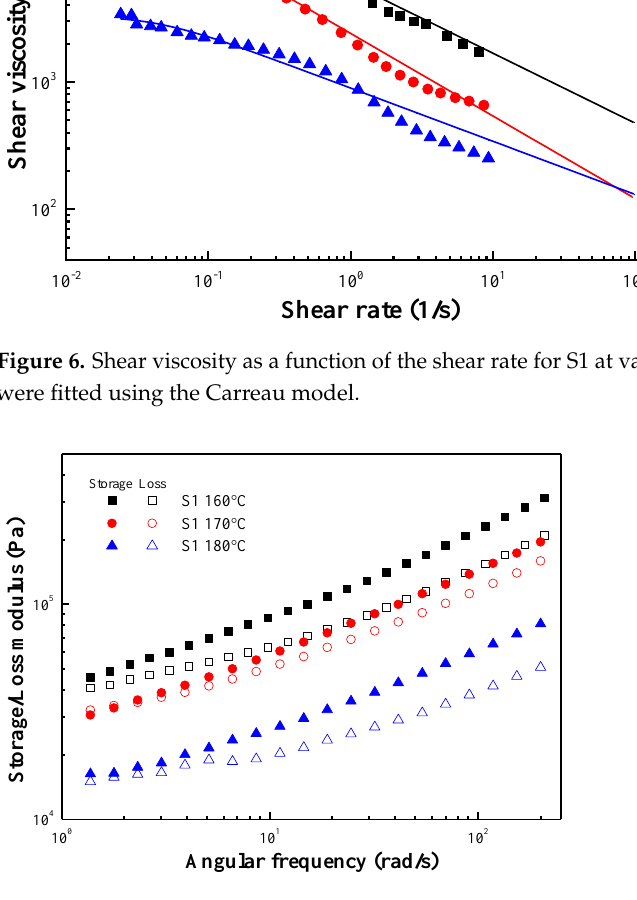
Figure 6. Shear viscosity as a function of the shear rate for S1 at various temperatures. The solid lines were fitted using the Carreau model. Table 2. Fitting parameters of the Carreau model for S1 under various temperatures.